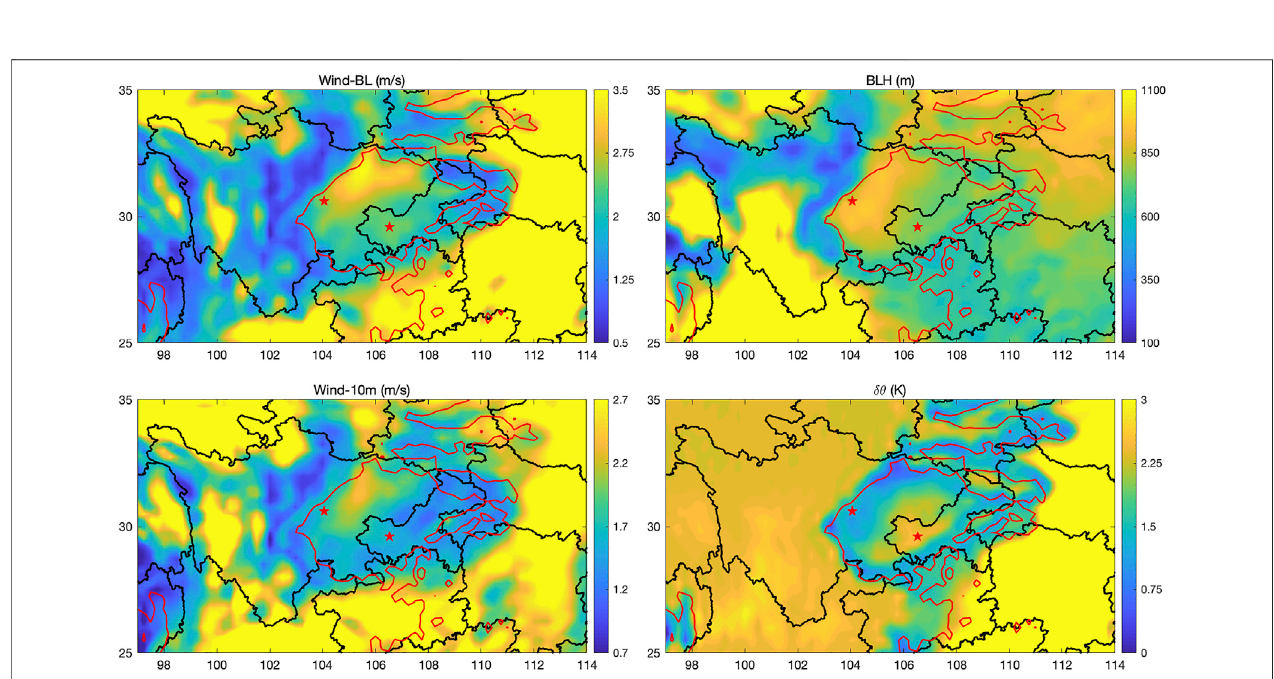
FIGURE5 | Distributionsof boundary layer wind speed (Wind_BL), boundary layer height (BLH), 10-m wind speed (Wind_10) and potentialtemperaturedifference between925 hPaand850 hPa( Δ θ )during thewintersfrom1979to2019intheSichuanBasin.Twored pentagrams indicate thelocationsofChengduandChongqing.